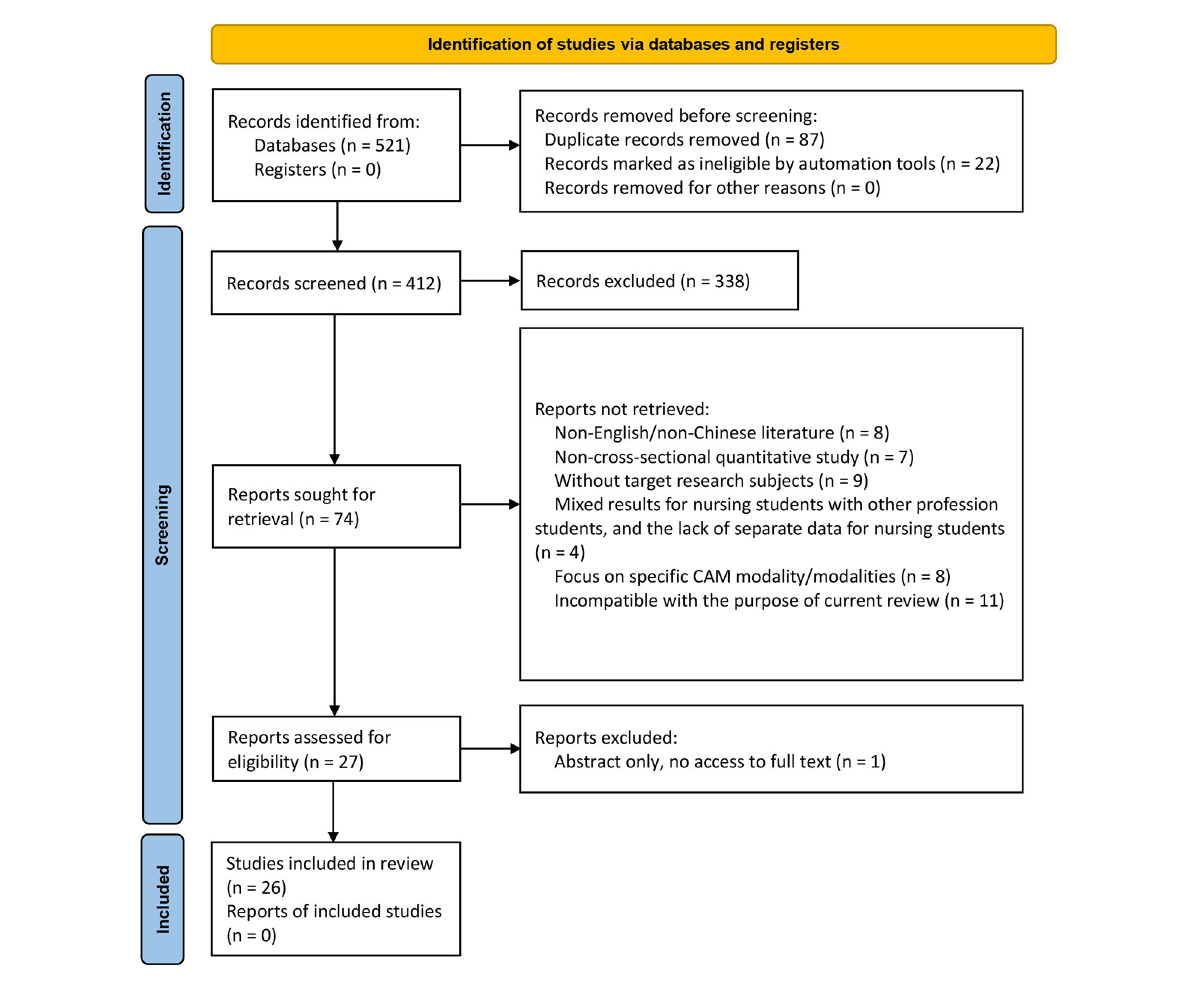
FIGURE1 Flow diagram of the study selection